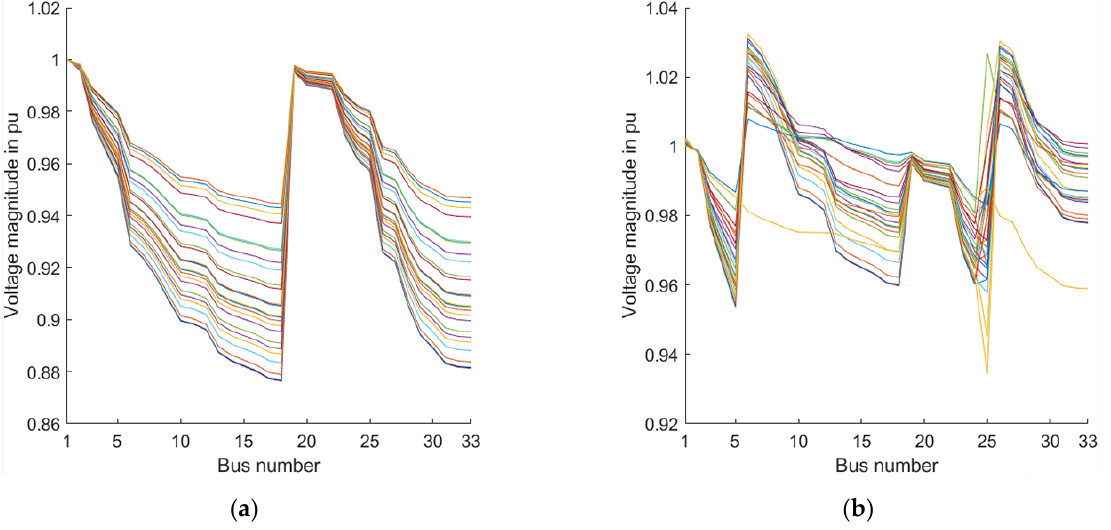
Figure 7. Daily, ( a ) base case, and ( b ) near-optimal voltage magnitudes when BESSs and tap changers are used.